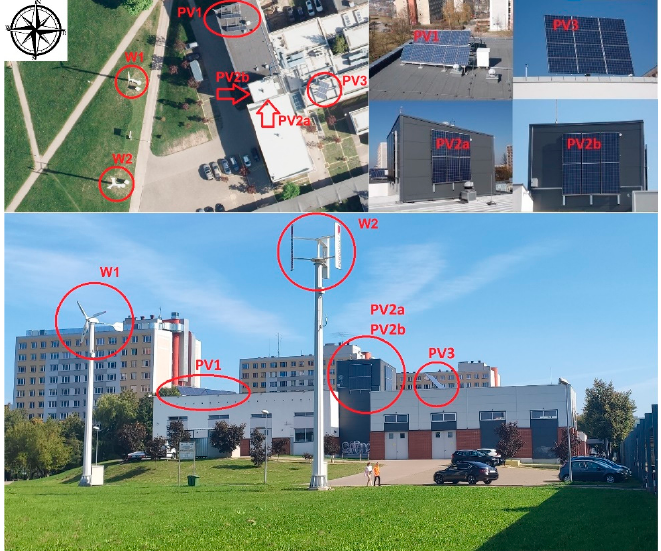
Figure 11. Hybrid power plant of the Faculty of Electrical Engineering of the Bialystok University of Technology. Table 1. Elements of the power plant under study.